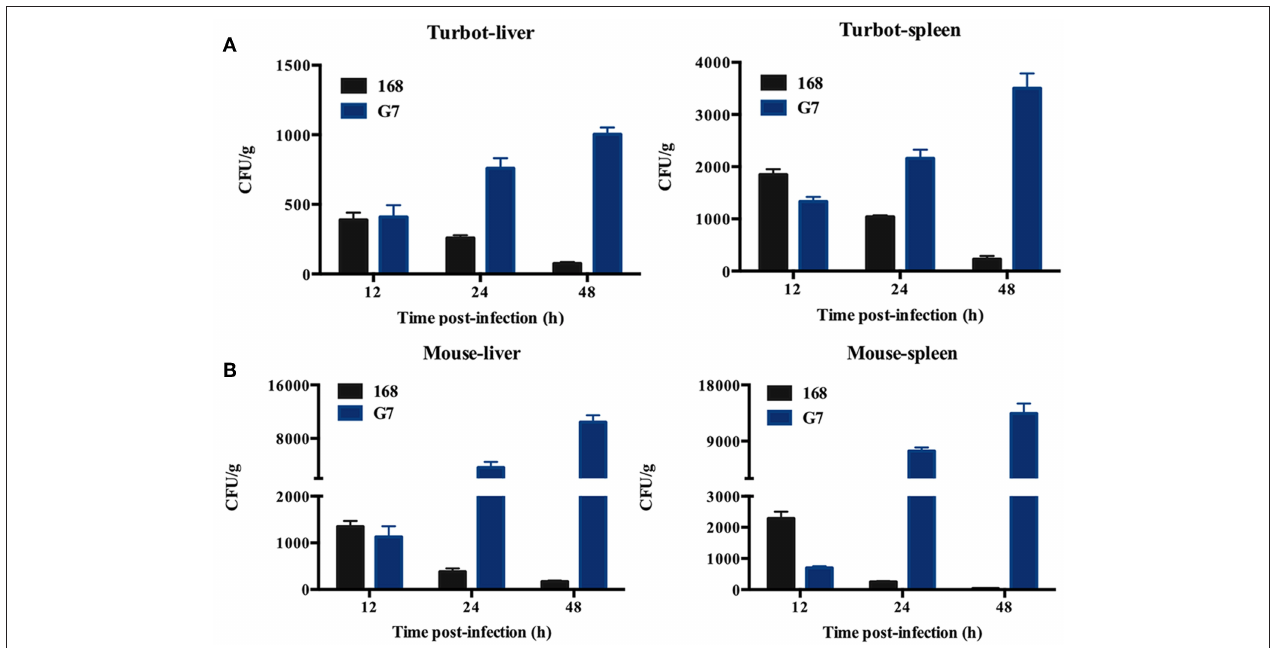
FIGURE 6 | Dissemination of G7 in fish and mice tissues. Turbot (A) and mice (B) were inoculated with G7 or strain 168 (control), and bacterial recovery from the tissues was determined at different time points. The results are the means of three experiments and shown as means ±